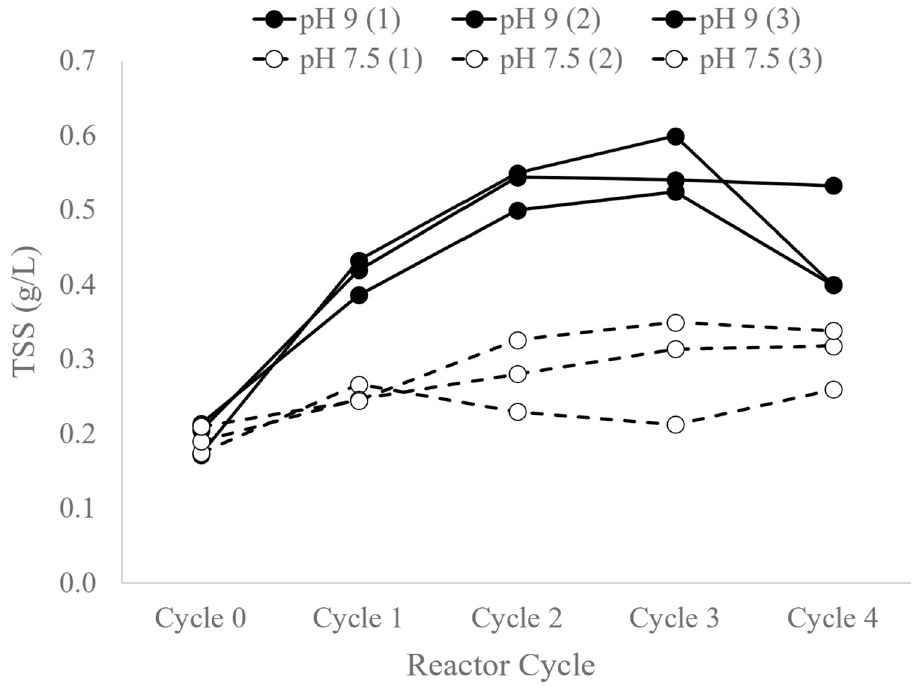
Fig 3. Reactor biomass concentrations. TSS concentration (g/L) in pH 7.5 and pH 9 reactors over the course of nutrient cycles for biological triplicate